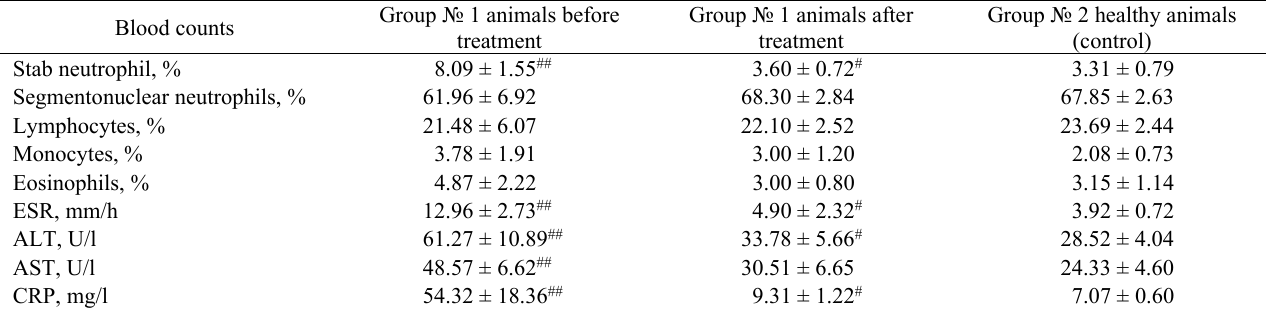
The value of absolute blood counts of the German Shepherd breed dogs ( М ± m, n =